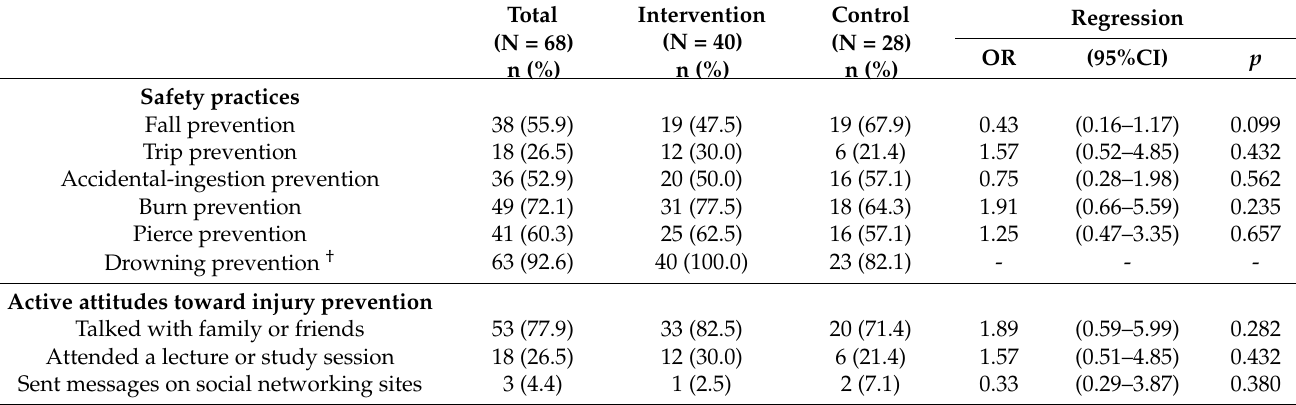
Table 3. Implementation of safety practices and active attitudes regarding injury